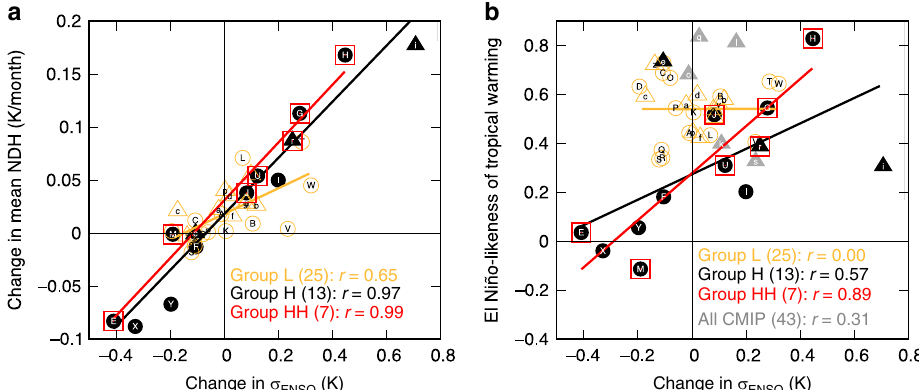
Fig. 6 ENSO amplitude change and tropical warming pattern. a Future change in the long-term mean of subsurface nonlinear dynamical heating (NDH) as a function of ENSO amplitude change. b El Niño-likeness of the tropical Paci fi c warming as a function of ENSO amplitude change. Triangles and circles indicate the CMIP6 and CMIP5 models, respectively, in group H (black, closed) and group L (orange, open). Red open squares represent the group HH models. Gray closed triangles represent 5 CMIP6 models unavailable for evaluating NDH variability (Table 1; see “ Methods ” section for details).